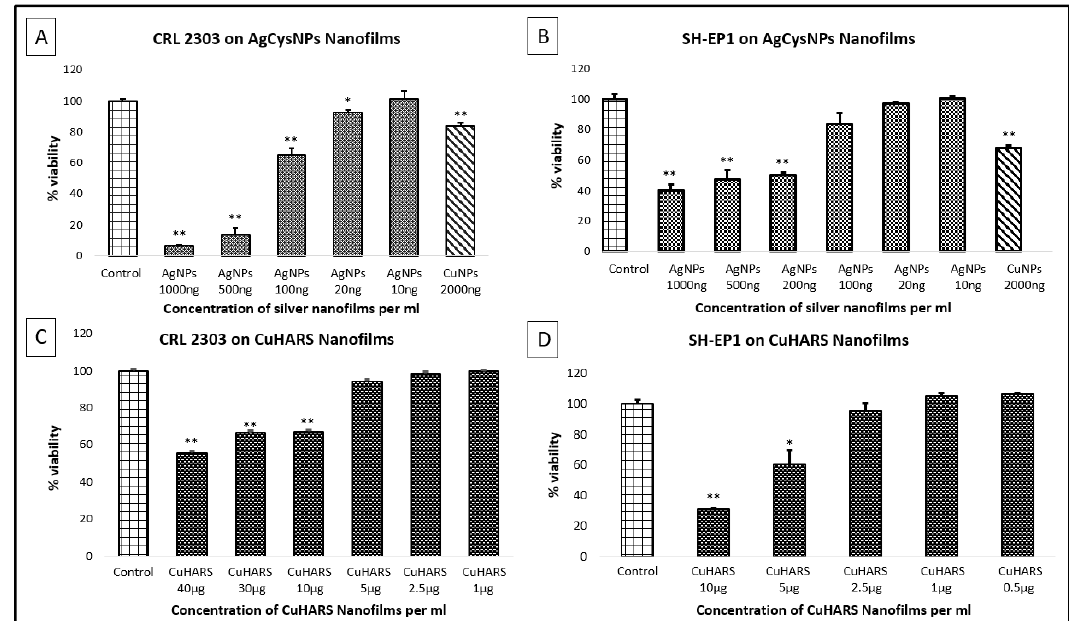
Figure 8. Toxicity testing of nanomaterials as films. CRL 2303 glioma cells at 40,000 per well were treated with AgCysNPs or CuNPs (Panel A ), at the indicated concentrations, or CuHARS (Panel C ), and tested for viability. SH-EP1 cells at 40,000 per well were grown in vitro for three days on nanofilms of the indicated materials, either AgCysNPs (Panel B ), or CuHARS (Panel D ). Upon termination, an MTT assay was carried out to test for cellular metabolic activity. Data for each condition are the average of n = 3 wells with standard error of the mean indicated. Data represent multiple platings of each cell type tested, with * denoting p < 0.05 and ** denoting p < 0.01 compared to control conditions. Y -axis = Viability normalized to % of controls (column 1 values). For evaluation of AgCysNPs (Panels A , B ), the right-most column = addition of CuNPs for comparative purposes at 2000 ng/mL. Controls were untreated cells (Panels A – D ).